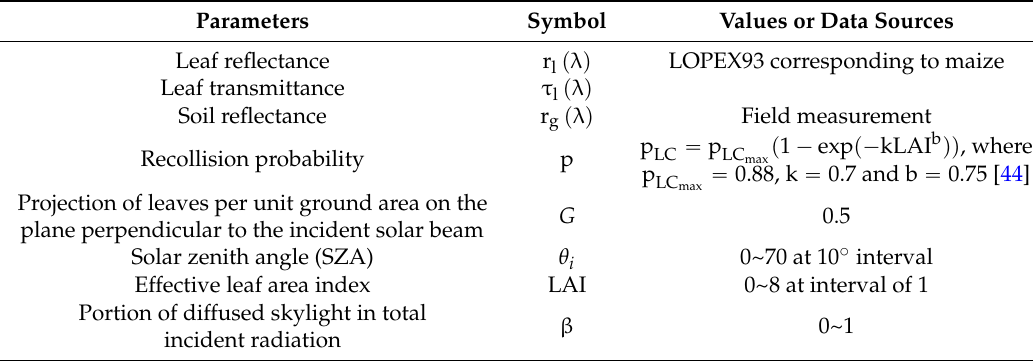
Table 2. Input parameters and variables of FAPAR-P